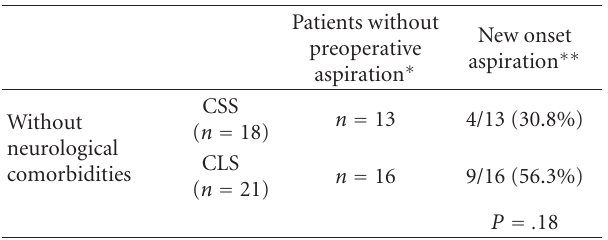
Table 1: New Onset Aspiration.